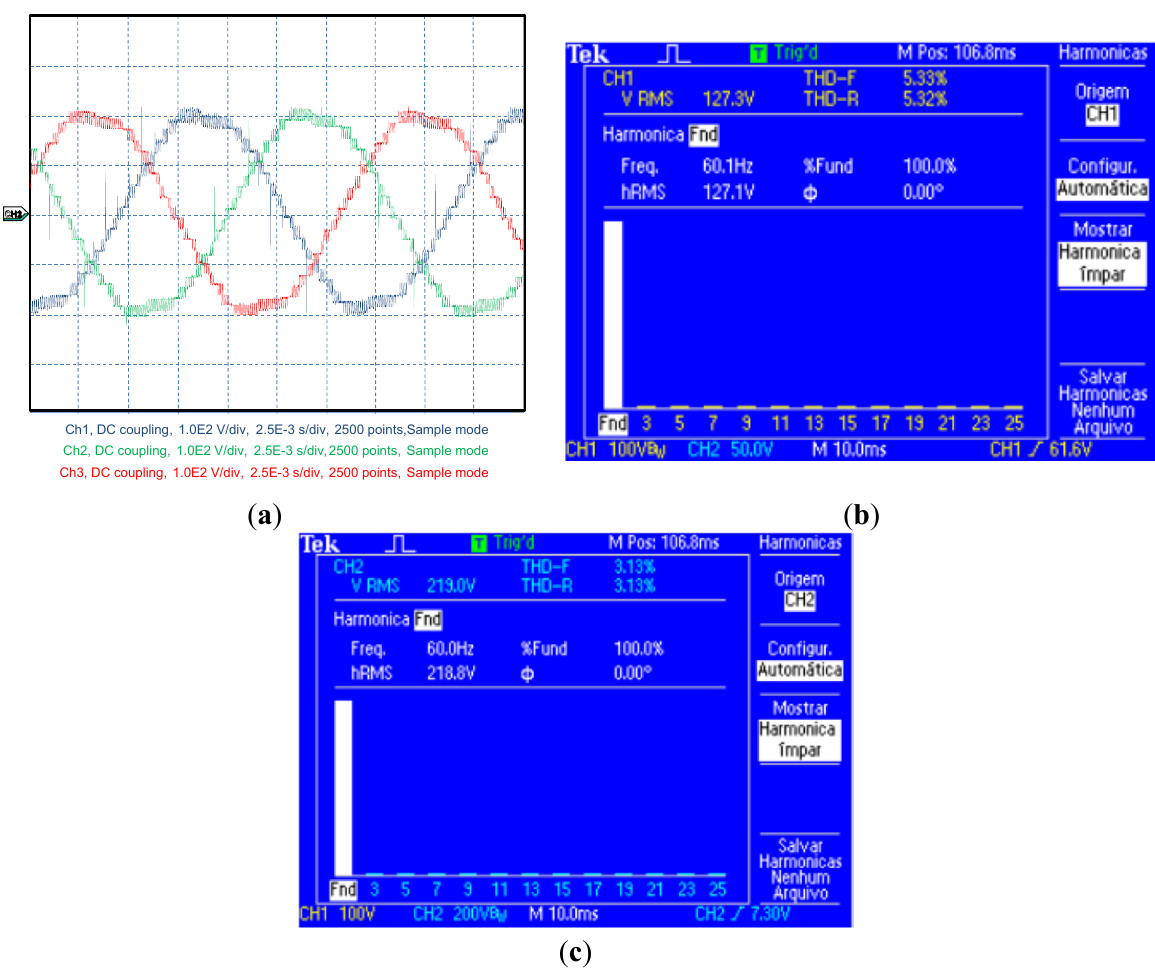
Figure 12. ( a ) Three-phase voltage converter waveform; ( b ) line-to-neutral THD; ( c ) line-to-line